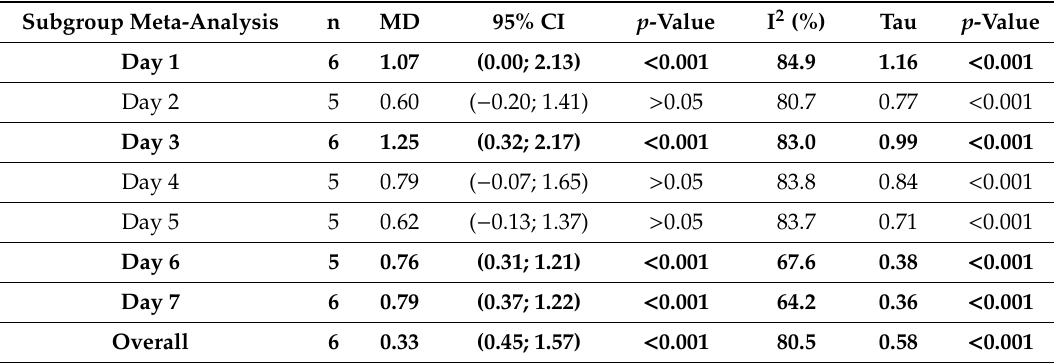
Table 3. Subgroup meta-analysis of VAS score from 1 to 7 days of follow-up.